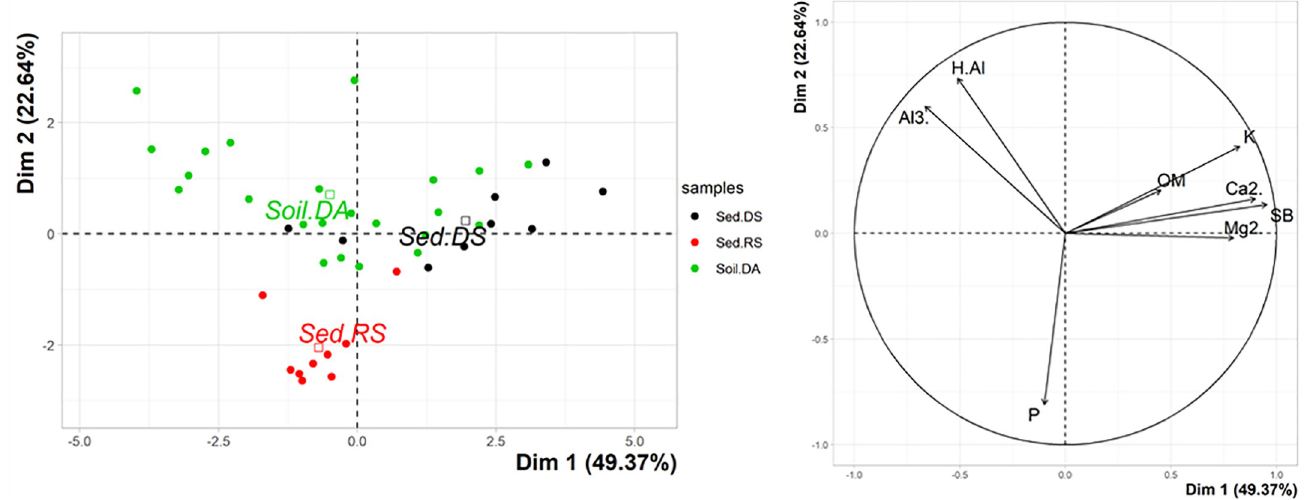
Fig 6. Analysis of main components of the sediment of the reference stream (RS) and degraded stream (DS) and soil of the degraded area (DA) in Catal ã o, GO, Brazil. Subtitle. Al3.-Exchangeable aluminum, Ca2.-Calcium ions, H.Al-Potential acidity, K-Potassium, Mg2.-Magnesium ions, OM-Organic matter, P-Phosphorus and SB-Sum of exchangeable bases.